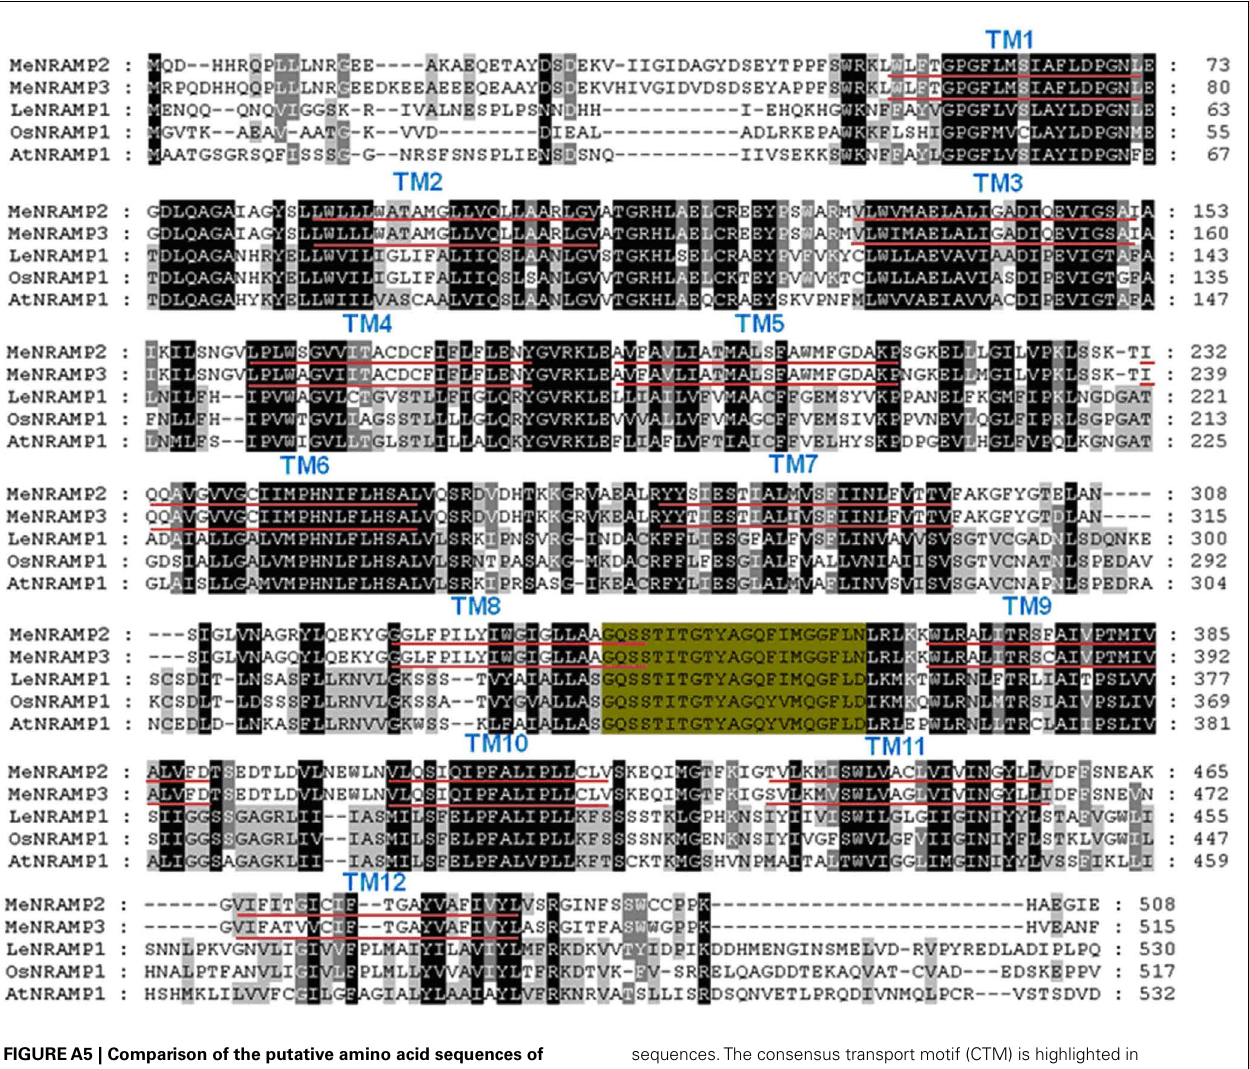
sequences.The consensus transport motif (CTM) is highlighted in green. Species designations are as follows: At, A. thaliana (AtNRAMP1); Os, O. sativa (OsNRAMP1); Le, Lycopersicum esculentum (LeNRAMP1); Me, Mannihot esculenta (MeNRAMP2,